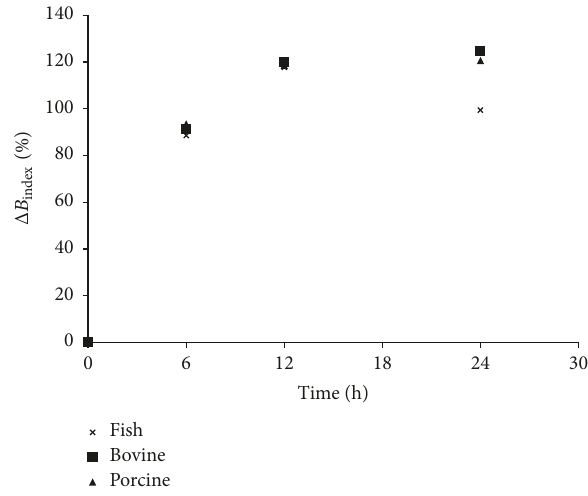
Figure 3: Change in the browning index due to the catalytic effect Figure 4: Change in the browning index due to combined catalytic of Cu ion on the degree of xylose-induced nonenzymatic browning effect of Cu 2+ and chymotrypsin digestion on the degree of Maillard of gelatin from different sources. Δ𝐵 : change in browning index. index reaction of gelatin from different sources. Δ𝐵 ing